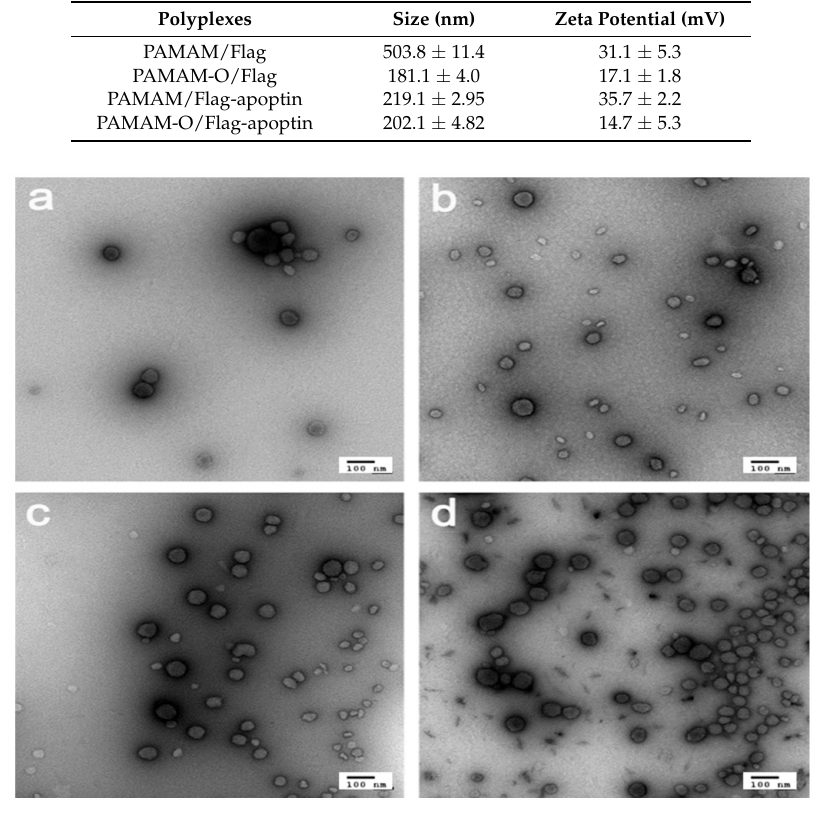
Figure 2. TEM images of polymer/Flag or Flag-apoptin polyplexes. ( a ) PAMAM/Flag polyplexes; ( b ) PAMAM/Flag-apoptin polyplexes; ( c ) PAMAM-O/Flag polyplexes; and ( d ) PAMAM-O/Flag-apoptin polyplexes. The scale bar is 100